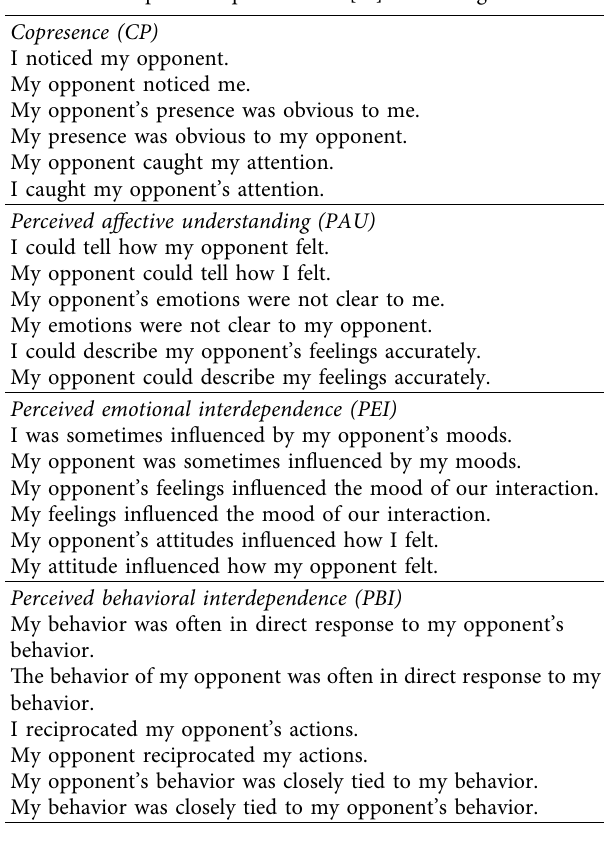
Table 3: Descriptive statistics (means and standard deviations) for the social presence dimensions (copresence (CP), perceived af- fective understanding (PAU), perceived emotional interdepen- dence (PEI), and perceived behavioral interdependence (PBI))